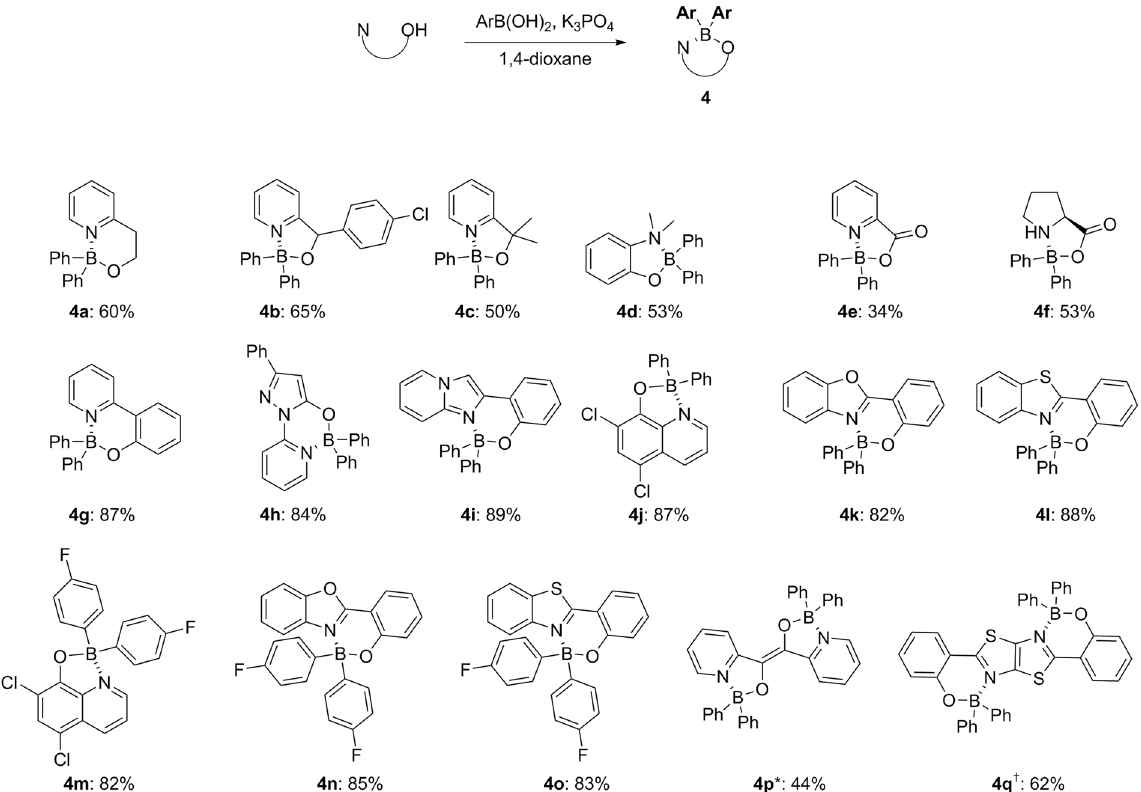
Figure 4. One-pot synthesis of organoborons from various N,O -bidentate ligands. Conditions: N,O -ligand (1.0 mmol), boronic acid (9.0 equiv), K 3 PO 4 (3.0 equiv) in 1,4-dioxane (0.02 M) at 110 °C with stirring for 20 hours, unless otherwise indicated. * 6 Equiv of K 3 PO 4 and 18 equiv of phenylboronic acid were used in 1,4-dioxane (0.01 M). † 6 Equiv of K 3 PO 4 and 18 equiv of phenylboronic acid were used in 1,4-dioxane (0.02